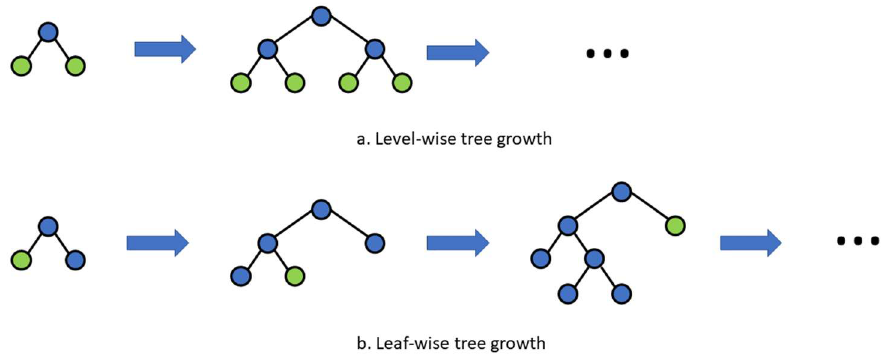
Figure 3. A pruning method of models using the gradient boosting algorithm. Each circle represents a node, and green is a leaf node.